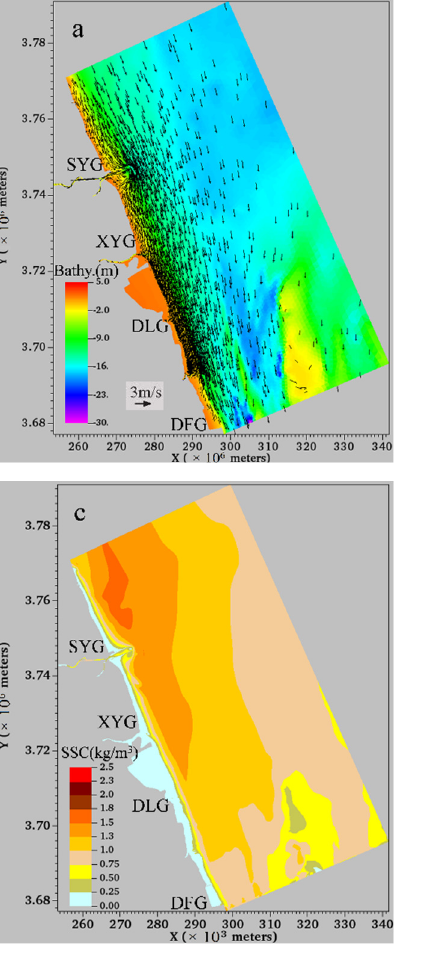
Figure 9. The flow at flood peak ( a ) and at ebb peak ( b ) and the depth-averaged suspended concentration at flood peak ( c ) and at ebb peak ( d ) of the spring tide. The coordinate axis unit is UTM